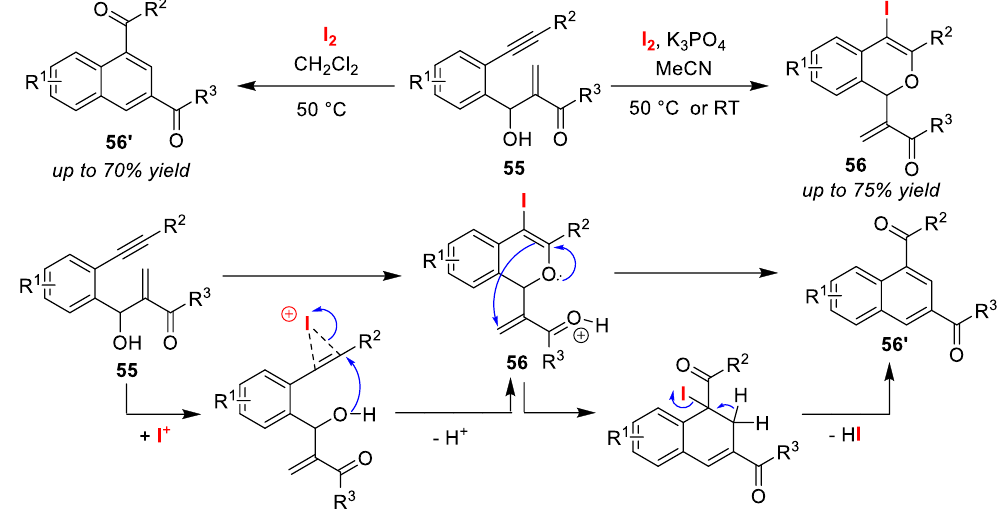
Figure 28. Selective synthesis of iso-chromene derivatives 56 and iodo-substituted naphthyl ketone derivatives 5 6′ via the halo-cyclization of 2-(2-phenylethynyl) Morita – Baylis – Hillman adducts 55 using I 2 .